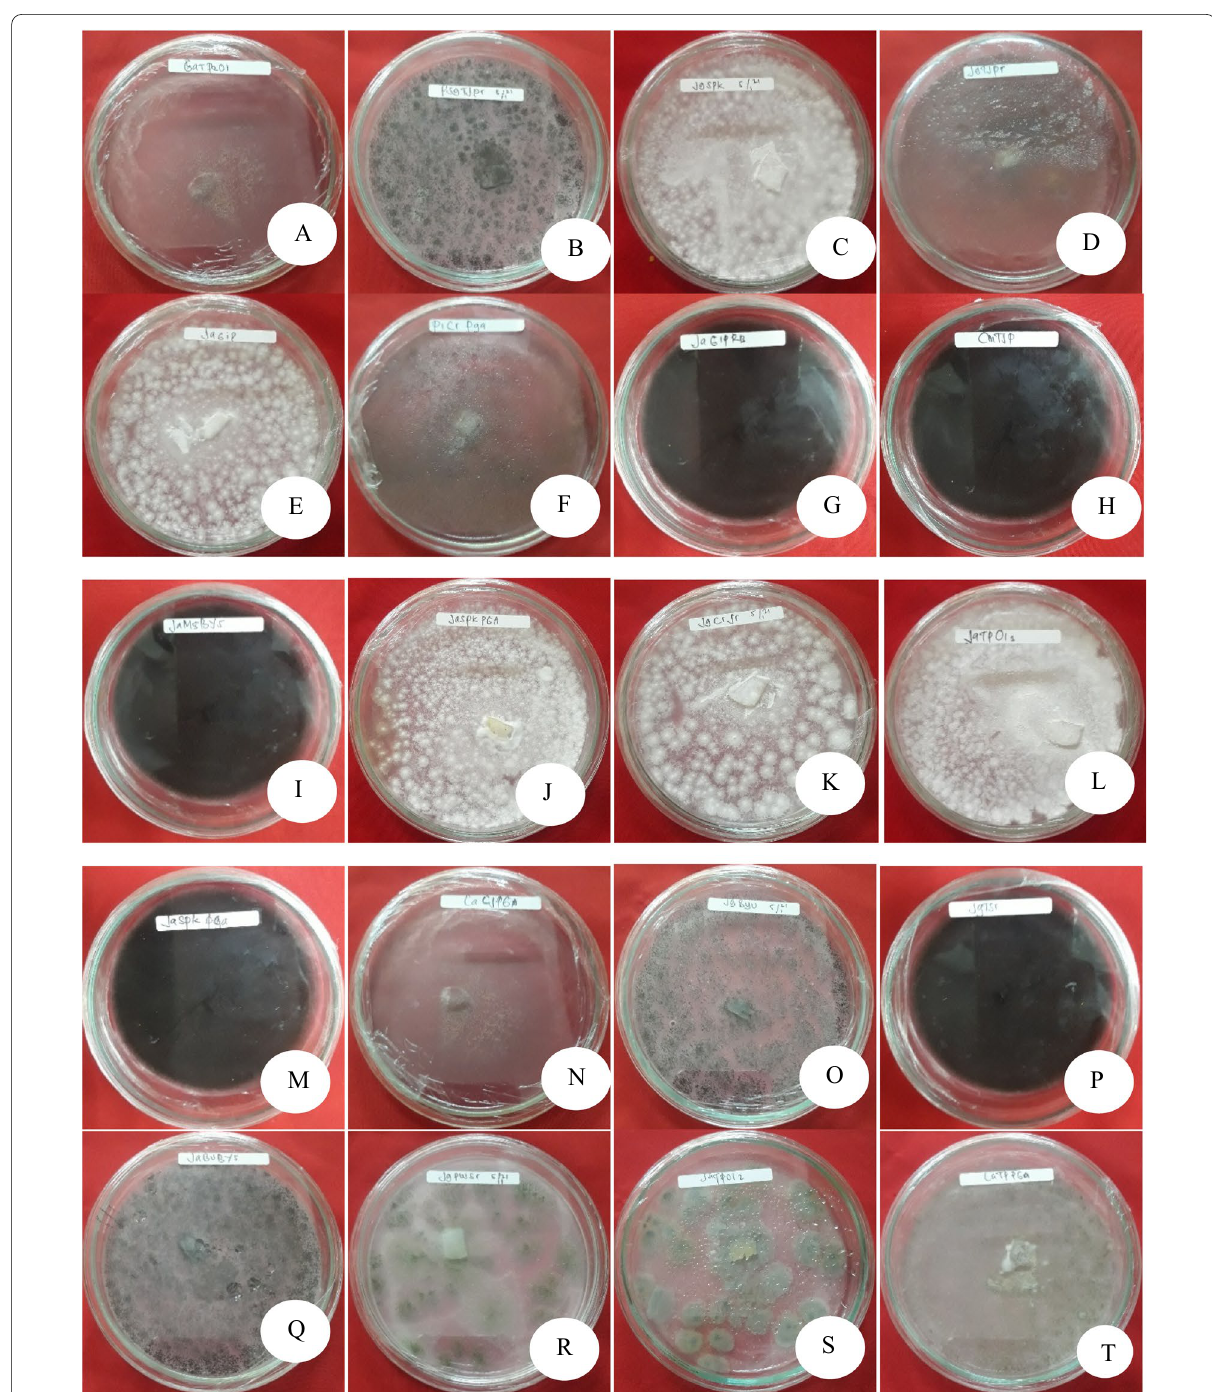
Fig. 2 Colony morphology of endophytic fungal species: Chaetomium sp. isolates of GaTpeOi ( A ), JgTjPr ( D ), PiCrPga ( F ), and CaCjPga ( M ); Aspergillus niger isolates of PsgTjPr ( B ), JgByU ( O ), and JaBuBys ( Q ); Beauveria bassiana isolates of JgSPK ( C ), JaGiP ( D ), JaSpkPGA(2) ( J ), JgCrJr ( K ), and JaTpOi(1) ( L ); Curvularia lunata isolates of JaGiPRB ( G ), CMTJP ( H ), JaMsBys ( I ), JaSpkPga(3) ( M ), and JgTgSr ( P ); Aspergillus flavus isolate of JgPWSR ( R ); Penicillium citrinum isolate of JaTpOi(2) ( S ); and Metarhizium anisopliae isolate of CaTpPga ( T